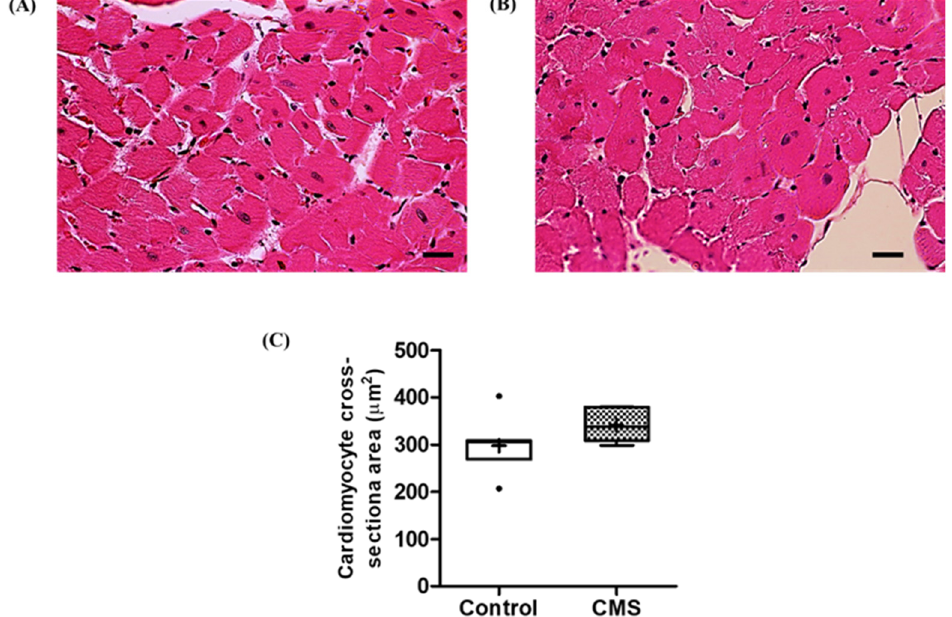
Figure 5. Histological sections of left ventricle in control ( A ) and CMS ( B ), and box plot of quantitative analysis of cardiomyocyte cross-sectional area ( C ). H&E, 400 × ; scale bar = 20 µ m; n = 7 for each group.